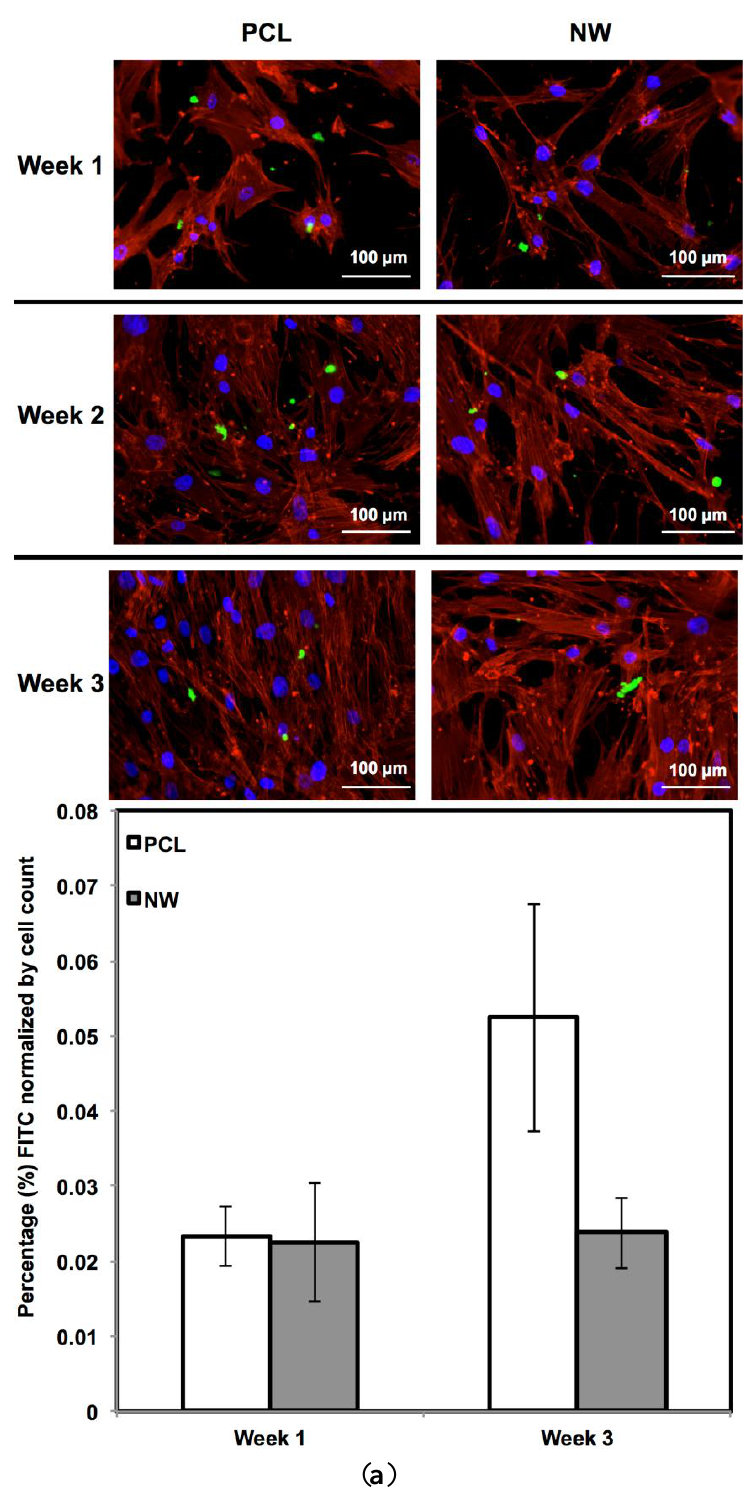
Figure 7. ( a ) Representative immunofluorescence images of ADSCs on PCL and NW for sox9 (green), actin (red) and nuclei (blue) after 1, 2, and 3 weeks of culture in chondrogenic conditions; ( b ) Representative immunofluorescence images of ADSCs on PCL and NW for col2 (green), actin (red) and nuclei (blue) after 1, 2, and 3 weeks of culture in chondrogenic conditions. Percentage of FITC-labeled sox9 ( a ) and col2 ( b ) were normalized by total number of cells within a particular